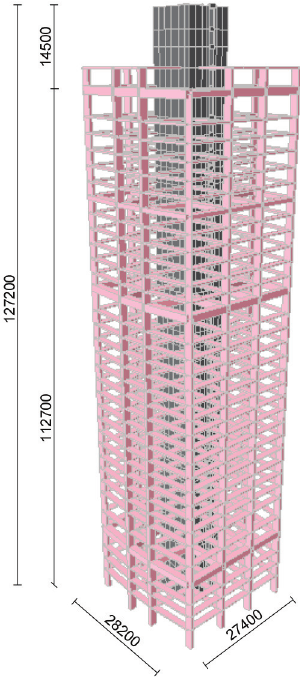
Fig. 3. Perspective view of the 37-storey building